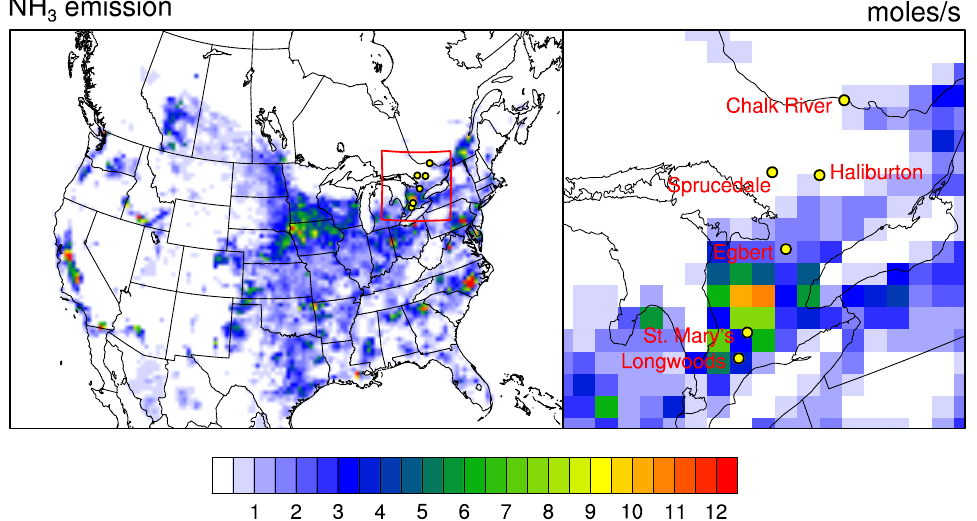
Fig. 1. Spatial distribution of gridded NH 3 emissions over North America (left panel) and locations of six measurement sites and their local NH 3 emission rates averaged over the simulation period (right panel, zooms into the area enclosed by red lines in the left